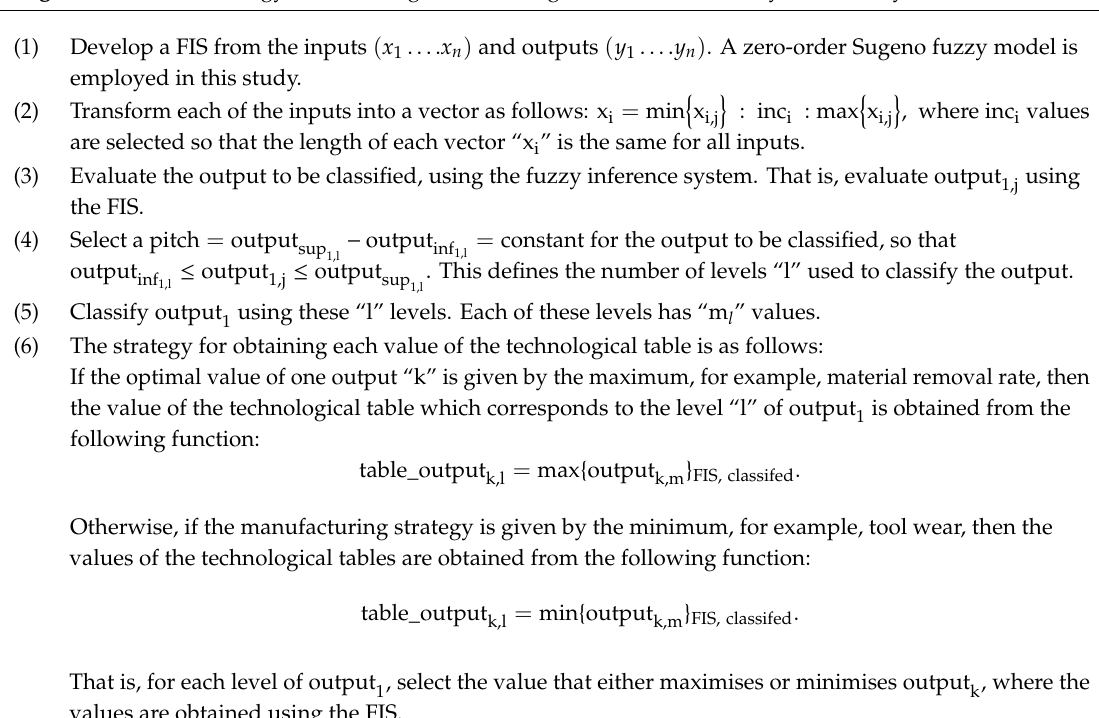
Algorithm 1. Methodology for obtaining the technological tables. FIS—fuzzy inference